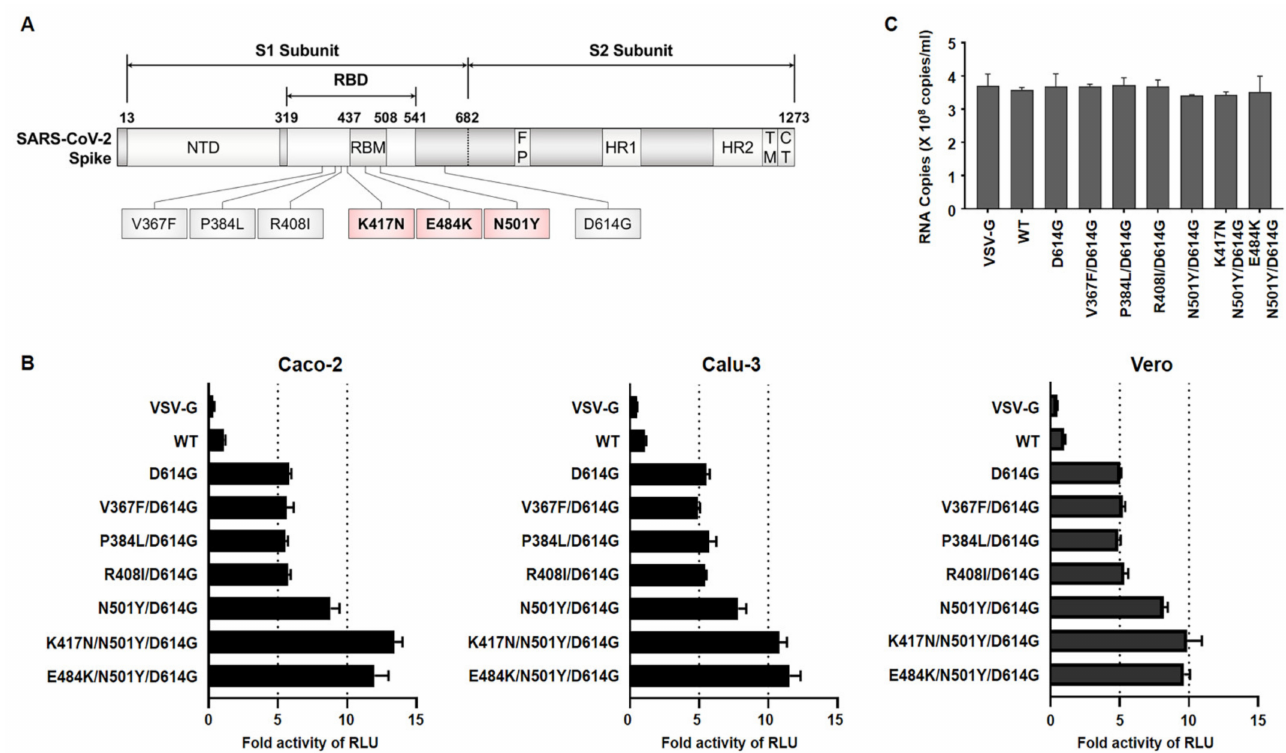
Figure 1. Infectivity of pseudoviruses harboring receptor-binding domain (RBD) mutants of spike protein either from Wuhan or B.1.351 lineages. ( A ) The illustration of amino acid changes selected RBD mutations for this study. Red-colored mutants represent the B.1.351 variant. Gray-colored mutants indicate the Wuhan variant. ( B ) Three different cell lines as indicated were infected with pseudoviruses with the Wuhan variant or South Africa variant. We also included VSV glycoprotein (VSV-G) protein-expressing pseudovirus as a negative control. The luminescence was measured after 24 h incubation and fold induction was calculated compared to SARS-CoV-2 Spike wild-type (WT). ( C ) The titer of each pseudovirus used in the experiment as shown in Figure 1B was quantified by RT-qPCR using primers targeting 3 (cid:48) LTR region of the firefly luciferase